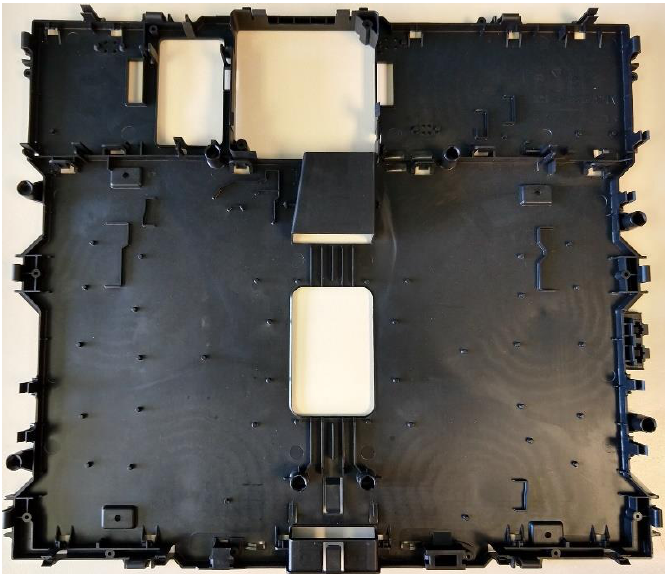
Figure 5. Induction cooktop—internal housing.